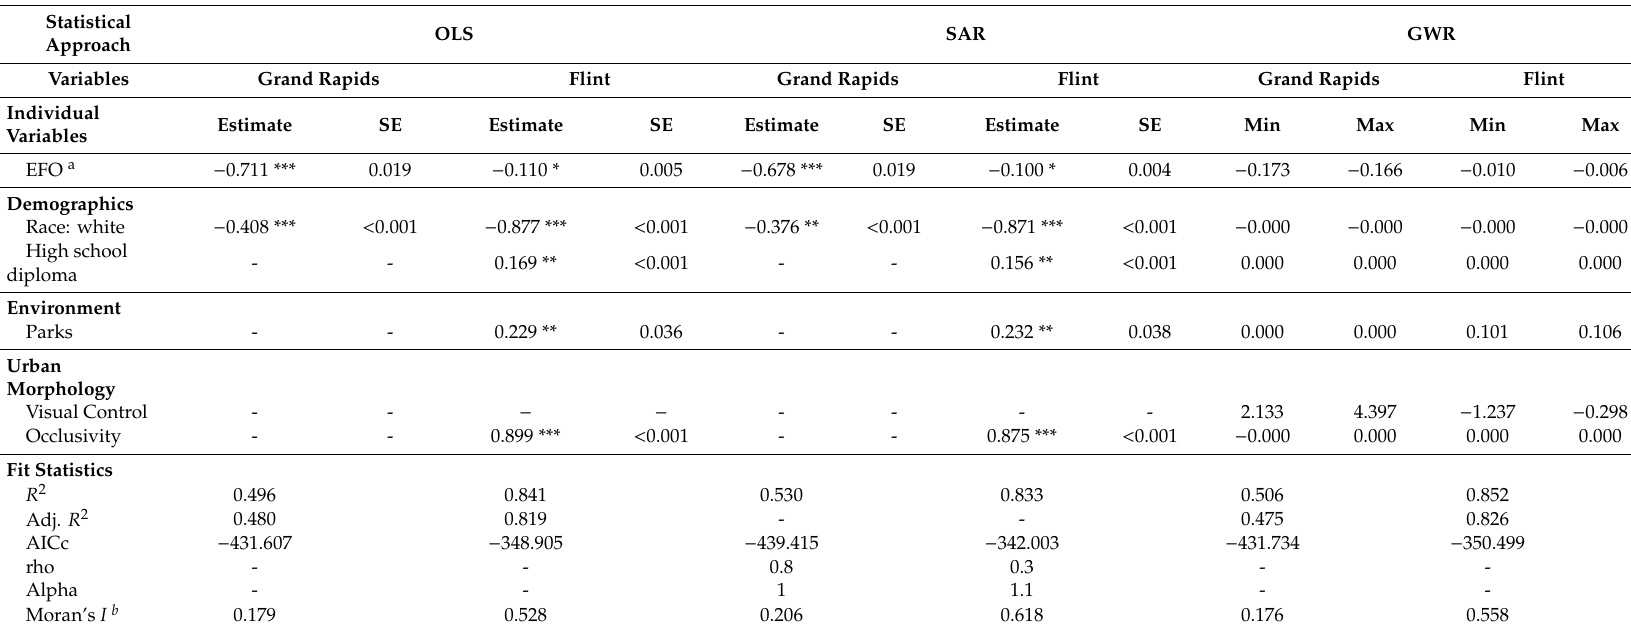
Table 7. Flint ( n = 60) and Grand Rapids ( n = 161) bicycling zone fully adjusted model coe ffi cients and diagnostic